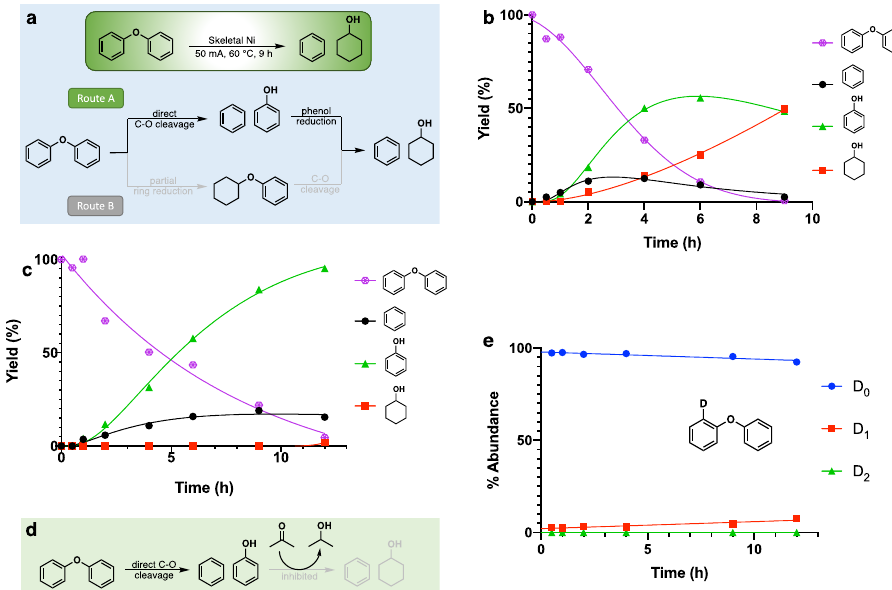
Fig. 2 Determination of the major cleavage pathway for diphenyl ether. a Two cleavage pathways of diphenyl ether. b Electrocatalytic hydrogenation (ECH) of diphenyl ether (8.33 mM) over a skeletal nickel electrode at 50 mA (current density 8 mA/cm 2 ) in the 30 mL of 0.1 M electrolyte mixture (2:1 pH 8 borate buffer:IPA) at 60 °C under ambient pressure (Standard Conditions). c ECH of diphenyl ether under standard conditions in mixture of buffer/IPA/ acetone (40:17:3). d Ring reduction inhibited by acetone reduction. e H/D isotope labeling of diphenyl ether with acetone treated skeletal